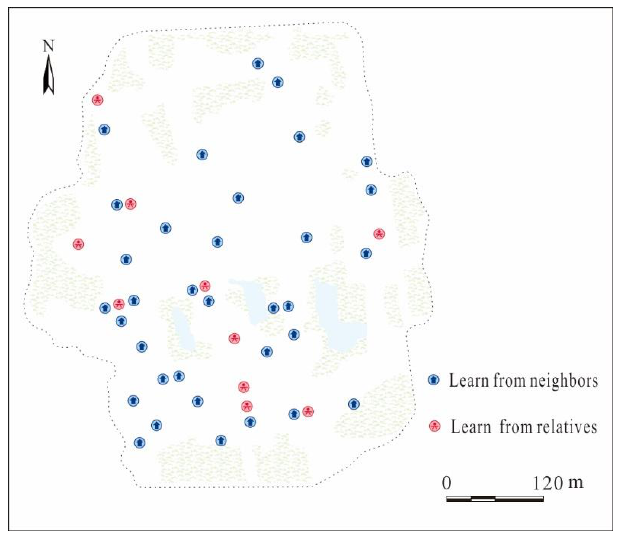
Figure 2. Learning approaches of farmers in Village A.